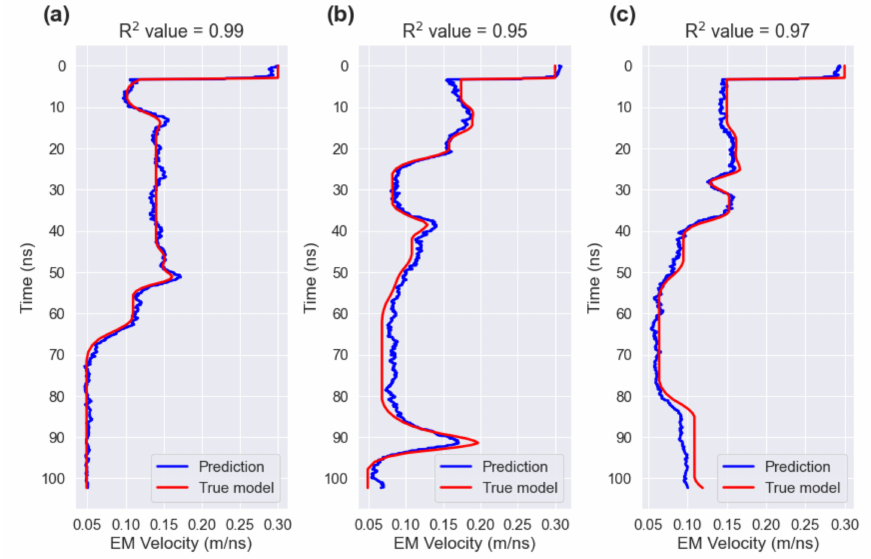
Figure 5. ( a – c ) show matching results of three randomly selected 1D true velocity models with corresponding predicted velocity models.